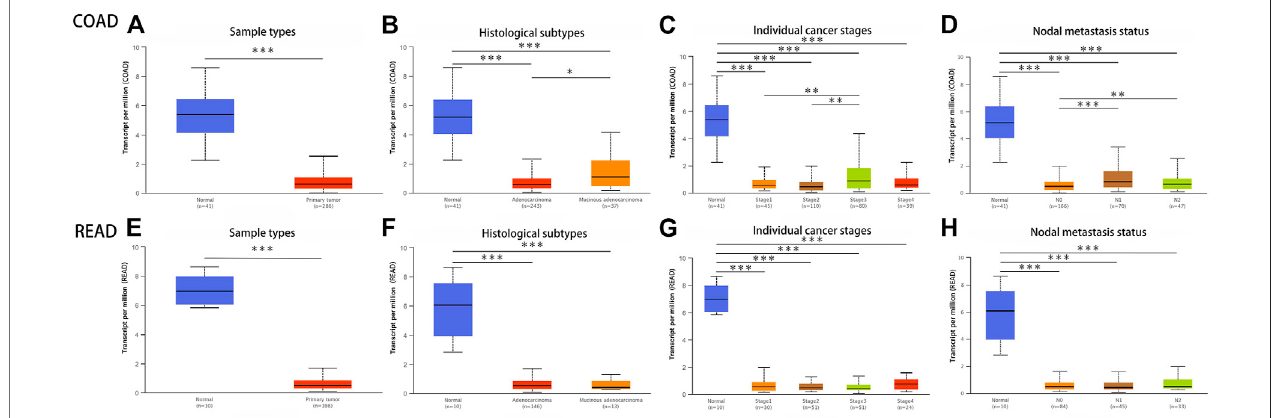
FIGURE 4 | The relationship between GNG7 expression and individual clinical parameters ofCOAD and READ in UALCAN database. (A) Differential expression of GNG7 in COAD tissues. Association of GNG7 mRNA expression with different COAD patients ’ individual cancer histologic subtypes (B) , tumor stages (C) , nodal metastasis (D) . (E) Differential expression of GNG7 in READ tissues. Association of GNG7 mRNA expression with different READ patients ’ individual cancer histologic subtypes (F) , tumor stages (G) , nodal metastasis (H)